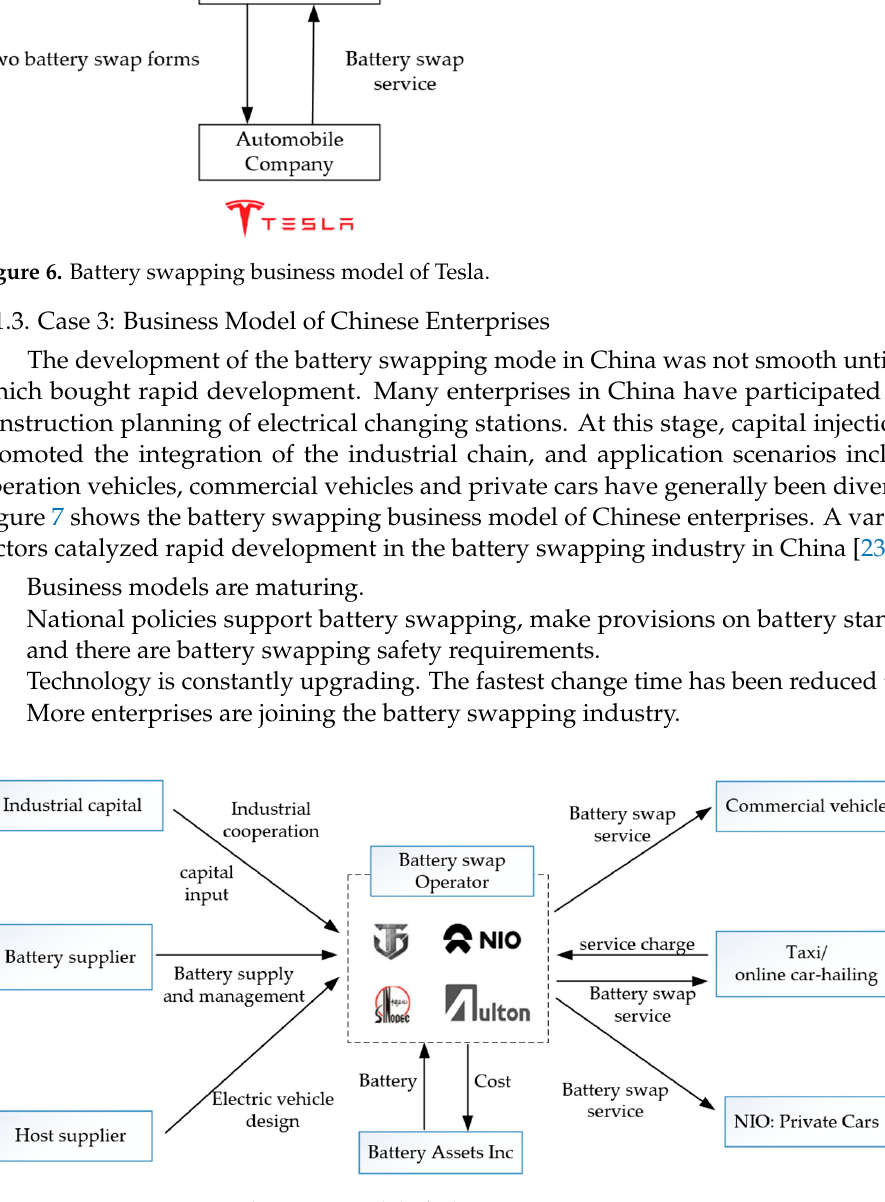
Figure 6. Battery swapping business model of Tesla.